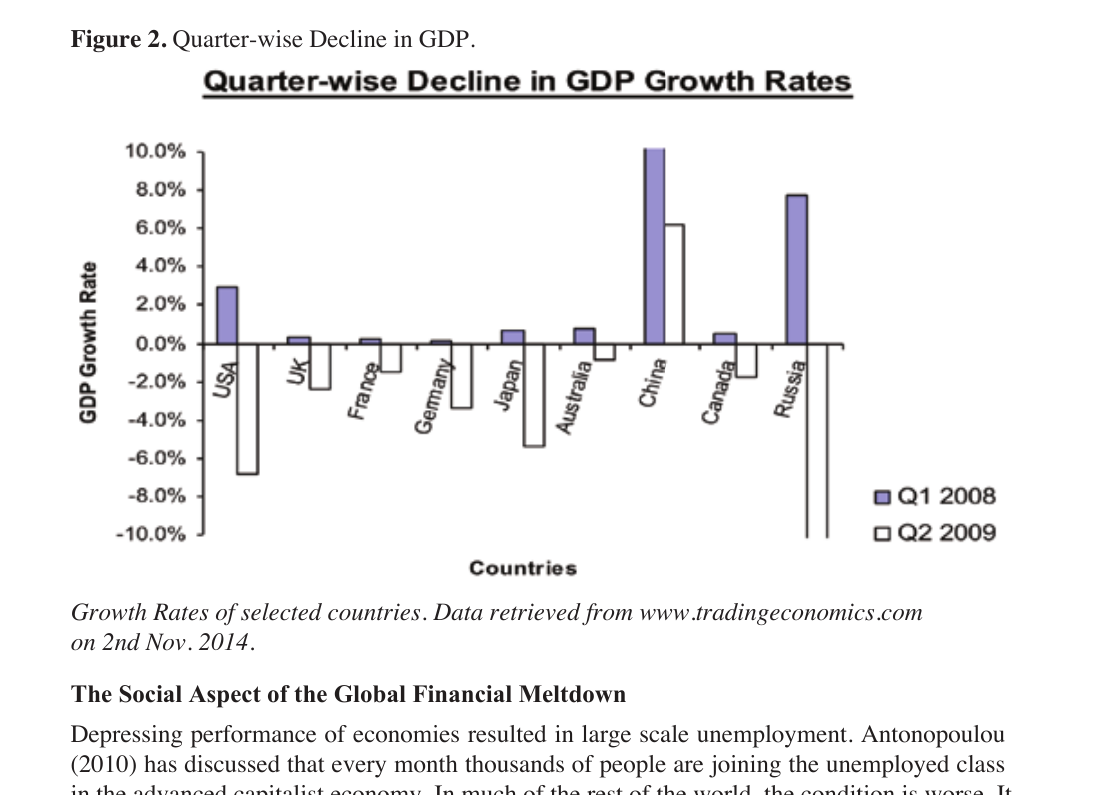
Figure 2. Quarter-wise Decline in GDP.